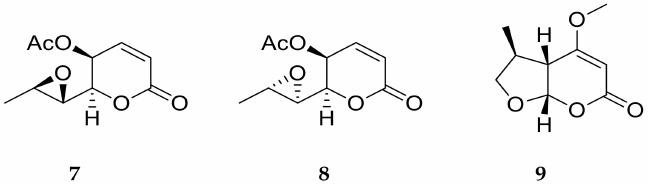
Figure 2. Structures of 5,6-dihydro-2-pyrones: asperlin, dia-asperlin, luteopyroxin ( 7 – 9 ). Luteopyroxin ( 9 ) was obtained from grapevines showing symptoms of Botryosphaeria (3 S ,3a R ,7a S )-4-methoxy-3-methyl-2,3,3a,7atetrahydro- 6H-furo [2,3b]pyran-6-one. In